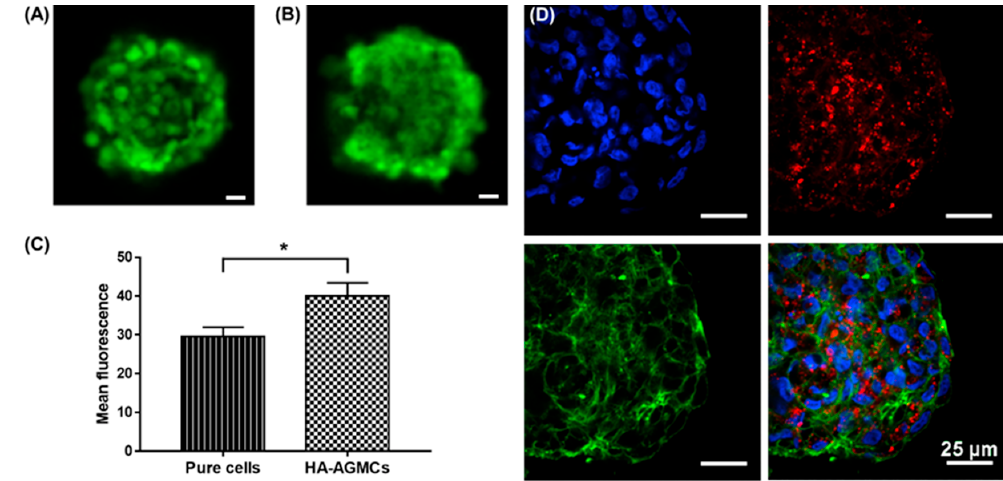
Figure 5. Confocal fluorescent image of cartilage tissue-mimetic pellets after 14 days culture. Live / Dead fluorescent image of ( A ) pure cells control group and ( B ) cells with HA-AGMCs group. Calcein AM (green), Ethidium homodimer-1 (red). ( C ) The fluorescence intensity in each pellet was measured by ImageJ and further analyzed by unpaired t -test ( P = 0.0123, n = 3). ( D ) Quantum dots were encapsulated in the shell of HA-AGMCs and used to visualize the localization of cartilage tissue-mimetic pellets consisting of DAPI (blue), actin (green), HA-AGMC (red quantum dots). As shown, chondrocytes remained viable in HA-AGMCs group and had stronger connection to ECM. Scale bar = 25 m.